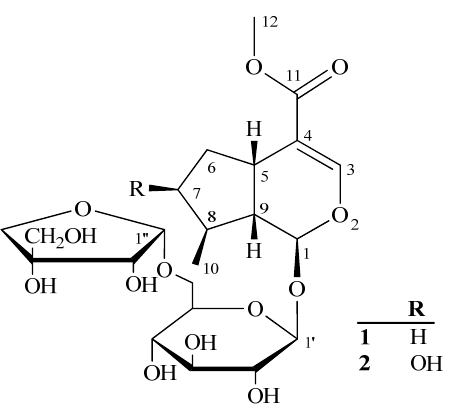
Figure 2 . Structures of 1 and 2